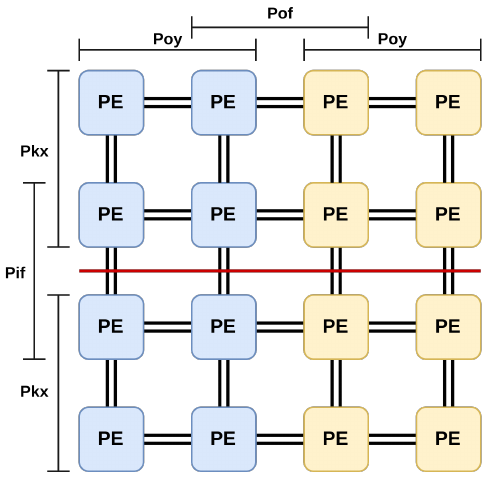
Figure 3. Example of row-stationary